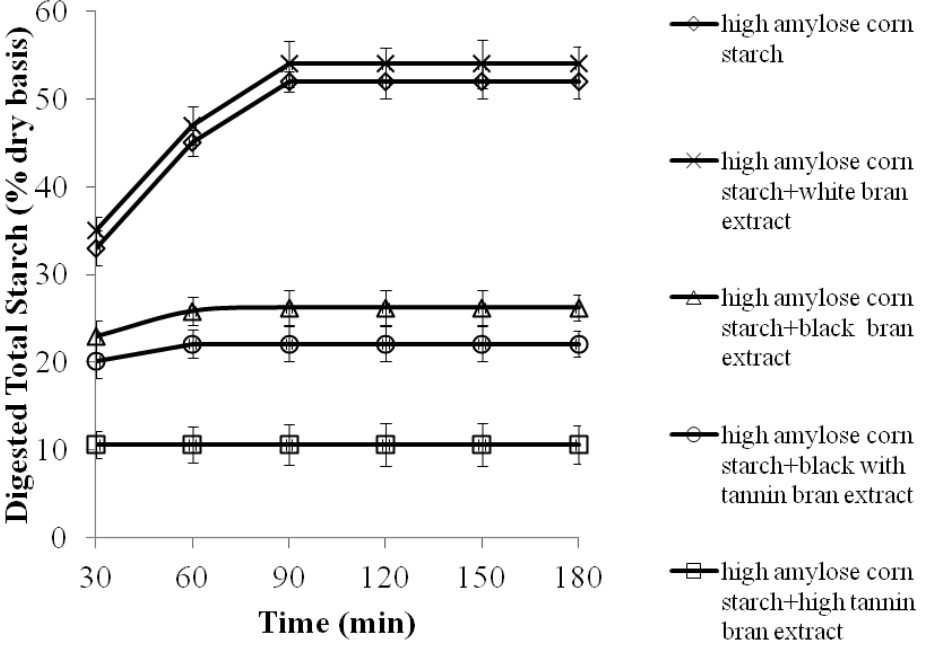
Figure 2. Starch digestibility of high amylose corn starch porridge made with sorghum bran extracts as a function of time (porridges used the equivalent of 50 mg of starch on a dry weight basis). Values are means ± standard error of n = 3 samples per